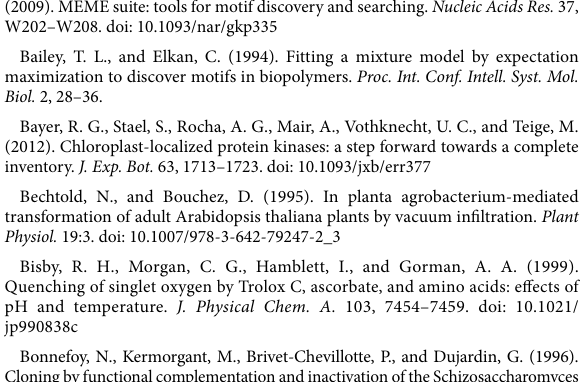
SUPPLEMENTARY FIGURE 1 The Bayesian phylogenetic tree of wheat ABC1K gene family. SUPPLEMENTARY FIGURE 2 Conserved amino acid conservation sequences in the ABC1 domain of the ABC1K gene family in wheat. VAVK and DFG motifs are marked. SUPPLEMENTARY FIGURE 3 The cis -acting element analysis in the TaABC1K gene promoters. (A) Distribution of cis-acting elements in each member of wheat ABC1K gene family. (B) Average number of cis -acting elements contained in subfamily members. SUPPLEMENTARY FIGURE 4 Expression profile of TaABC1K genes in wheat different tissues and developmental stages (A) and abiotic stresses (B) . SUPPLEMENTARY FIGURE 5 Identification of abc1k3/6 mutant, TaABC1K3/6 overexpressed plants and complement plants. (A) Using Arabidopsis genomic DNA as modle, chimeric primers were designed for PCR identification of T3 generation TaABC1K3/6 overexpressed plants and complement plants, Lines 1–15 are overexpressed plant samples (complement plants), Line 16 is wild type negative control, and Line17 is plasmid positive controls. (B) The Arabidopsis mutant purchased from the Salk site was T-DNA insertion mutation, the abc1k3 mutant was SALK_128696, and the abc1k6 mutant was